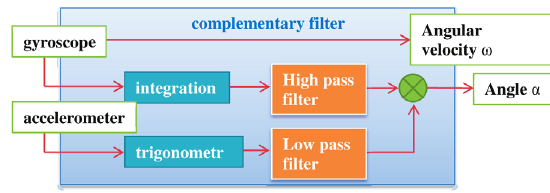
Fig. 17. The general system of data